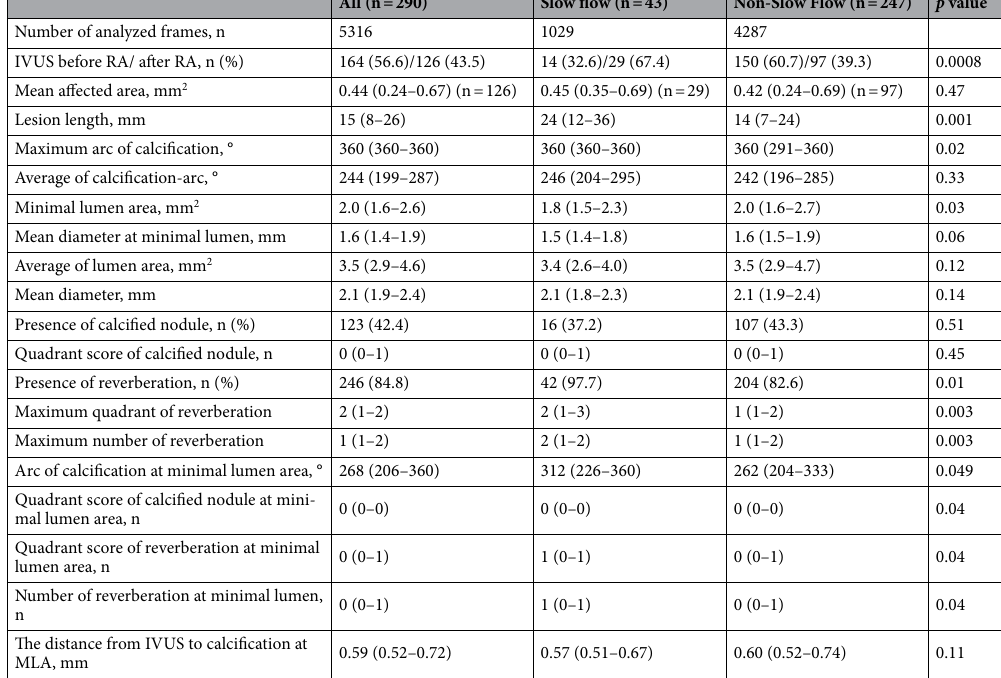
Table 3. Comparison of IVUS findings between the slow flow and non-slow flow groups. Values are presented as median (interquartile range), or n (%) for categorical variables. IVUS intravascular ultrasound.